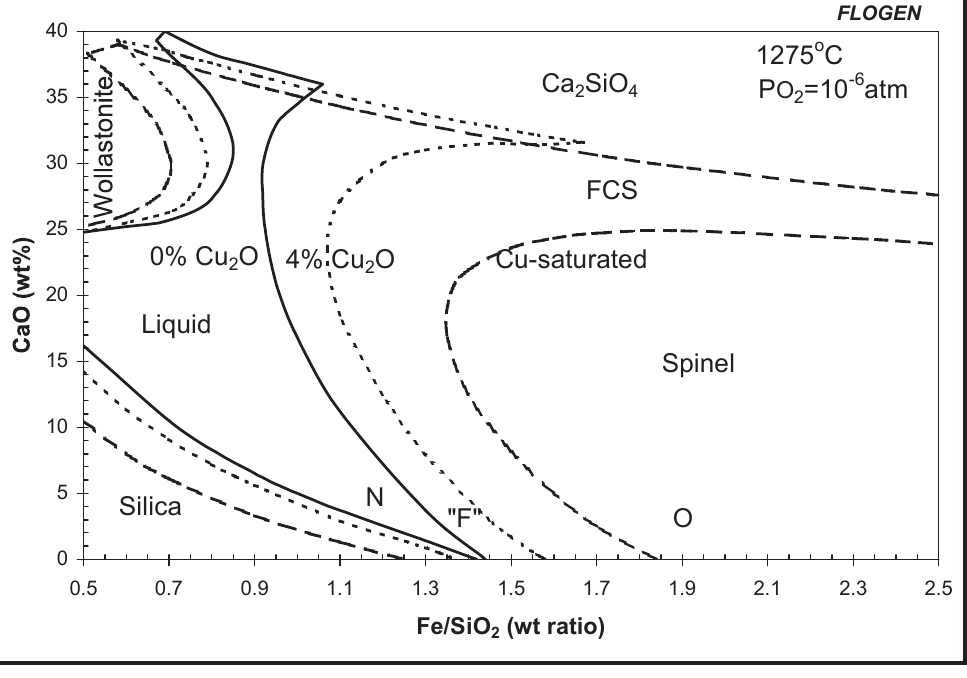
Figure 11. Variation of liquid region of FeO x -SiO 2 -CaO slag by addition of Cu 2 O at 1275°C and P O “F”: region of “fayalite” slag; “FCS”: region of ferrous calcium